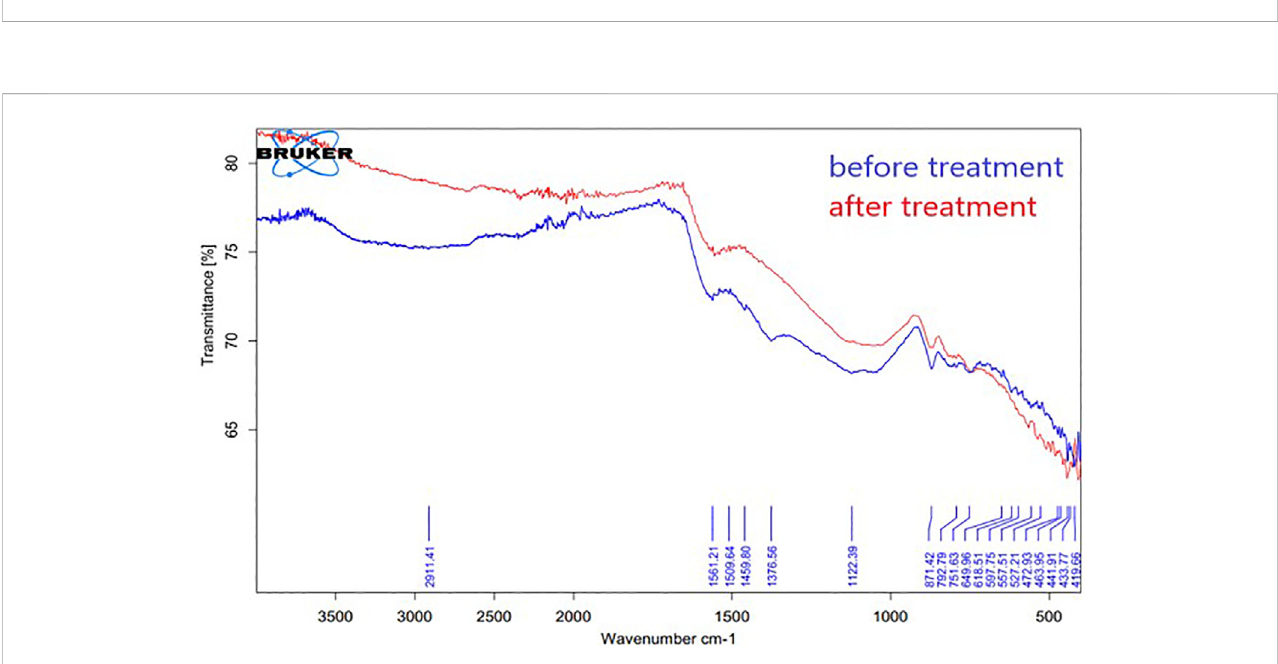
FIGURE 5 Infrared spectrum of char